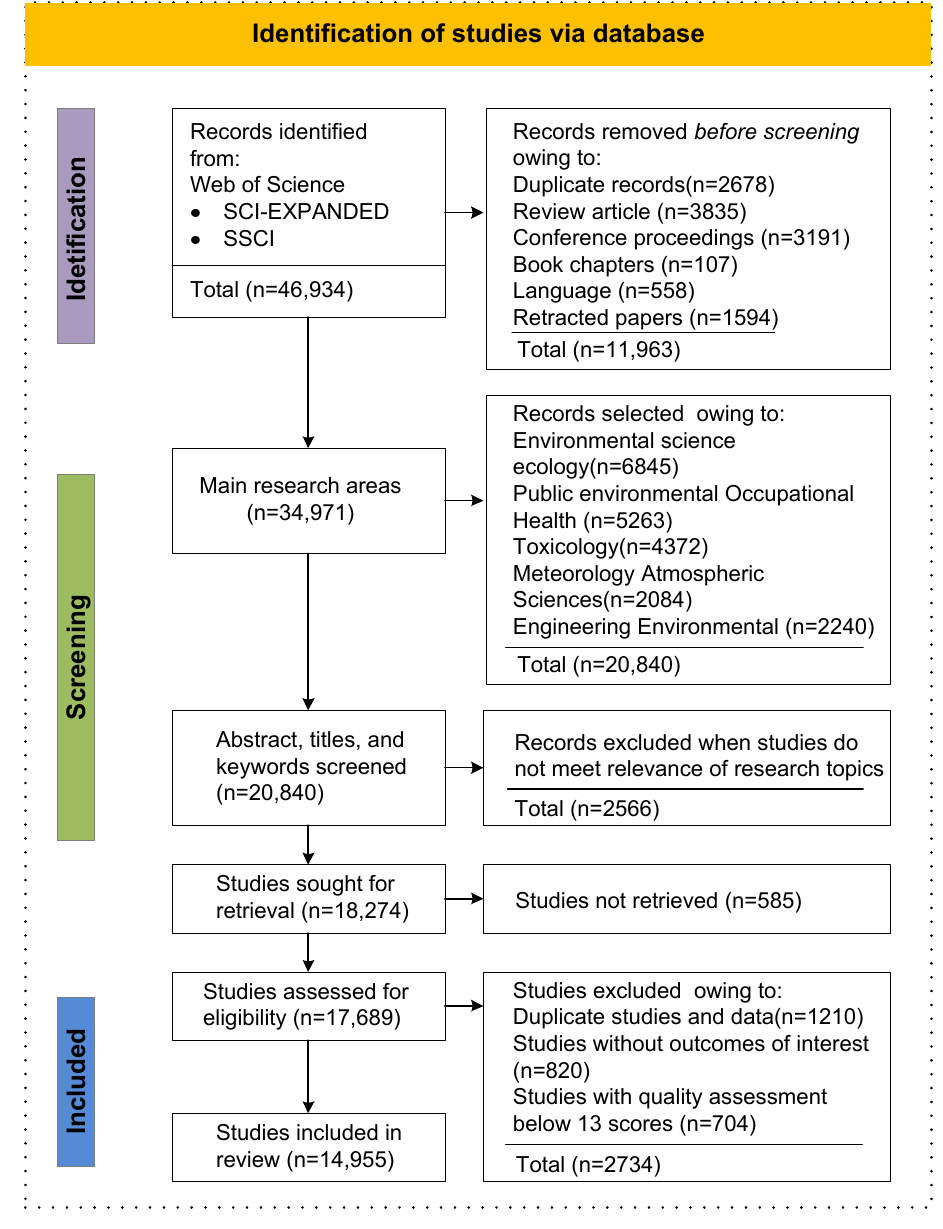
Figure 1. Framework of literature search, analysis, and